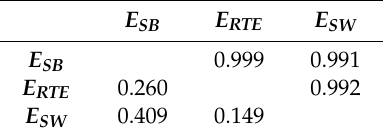
Figure 11. Evapotranspiration around the survey field on date 3 July obtained from SEBAL with RTE (left) and SW (right) correction methods of atmosphere e ff ects on LST. Table 5. Comparison of actual evapotranspiration (ETa) estimated over the area presented in Figures 10 and 11 with SB, RTE, and SW methods based on 3 July 2019 Landsat scene. Correlation coe ffi cient is presented above the diagonal and mean di ff erences below it (mm / d, column minus row entries). E